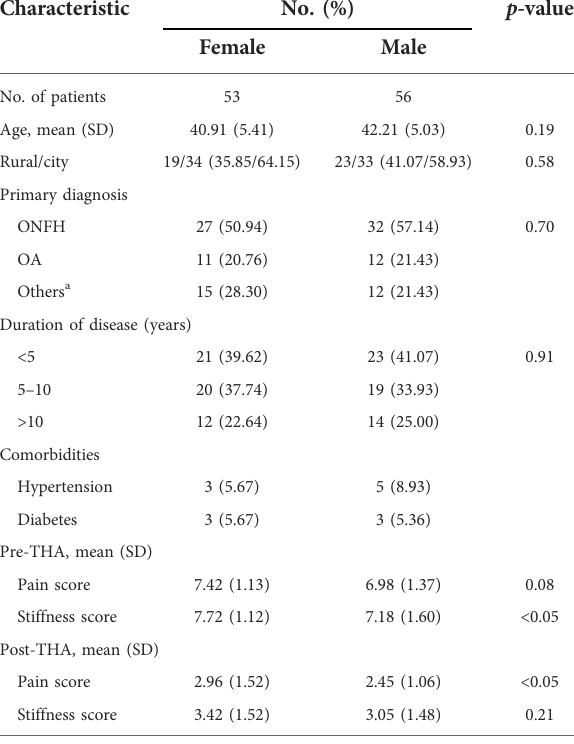
TABLE 1 Demographic characteristics of